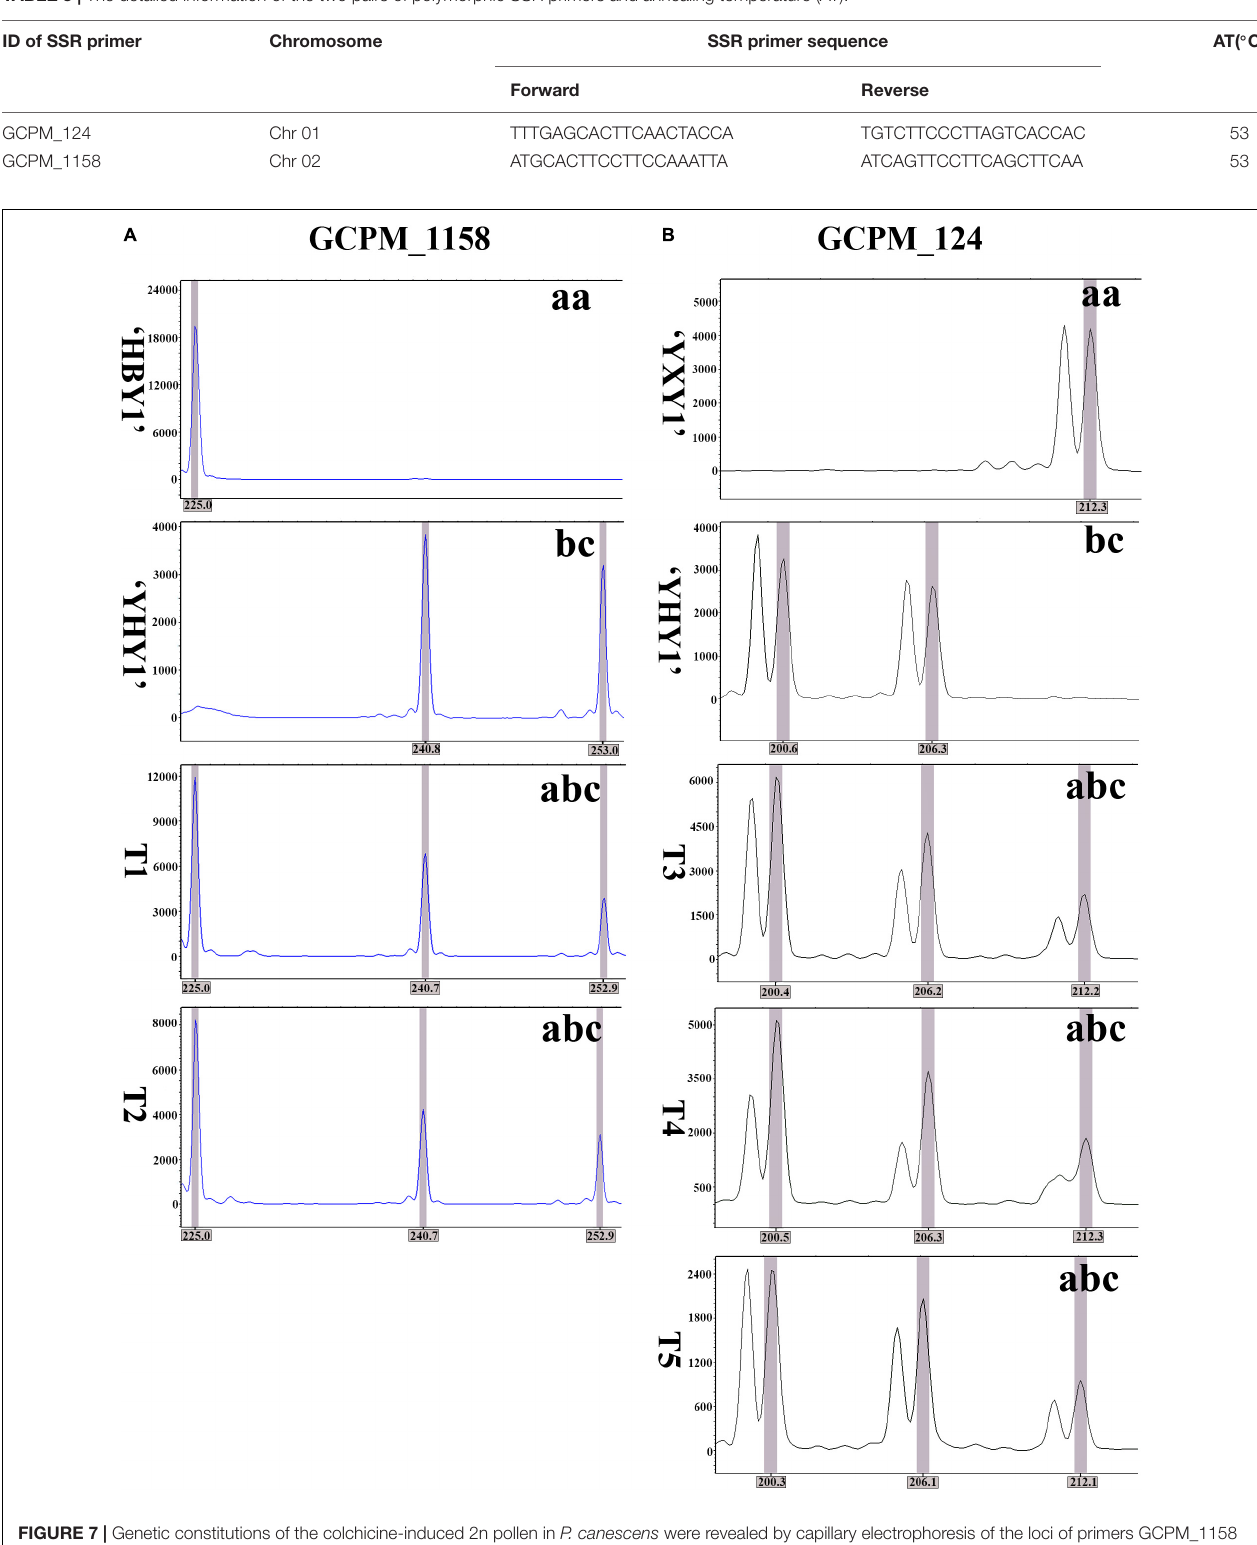
TABLE 3 | The detailed information of the two pairs of polymorphic SSR primers and annealing temperature (AT). ID of SSR primer